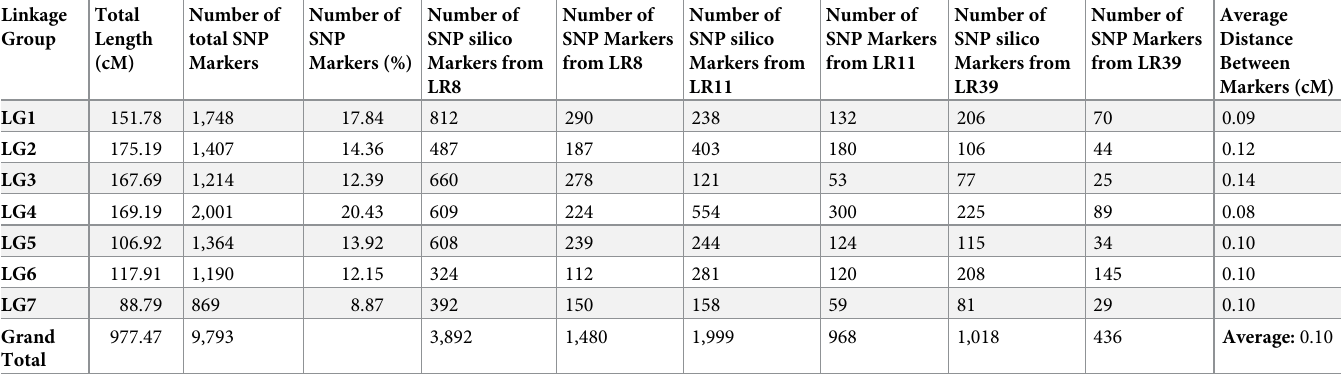
Table 2. Characteristics of the linkage groups of the lentil consensus